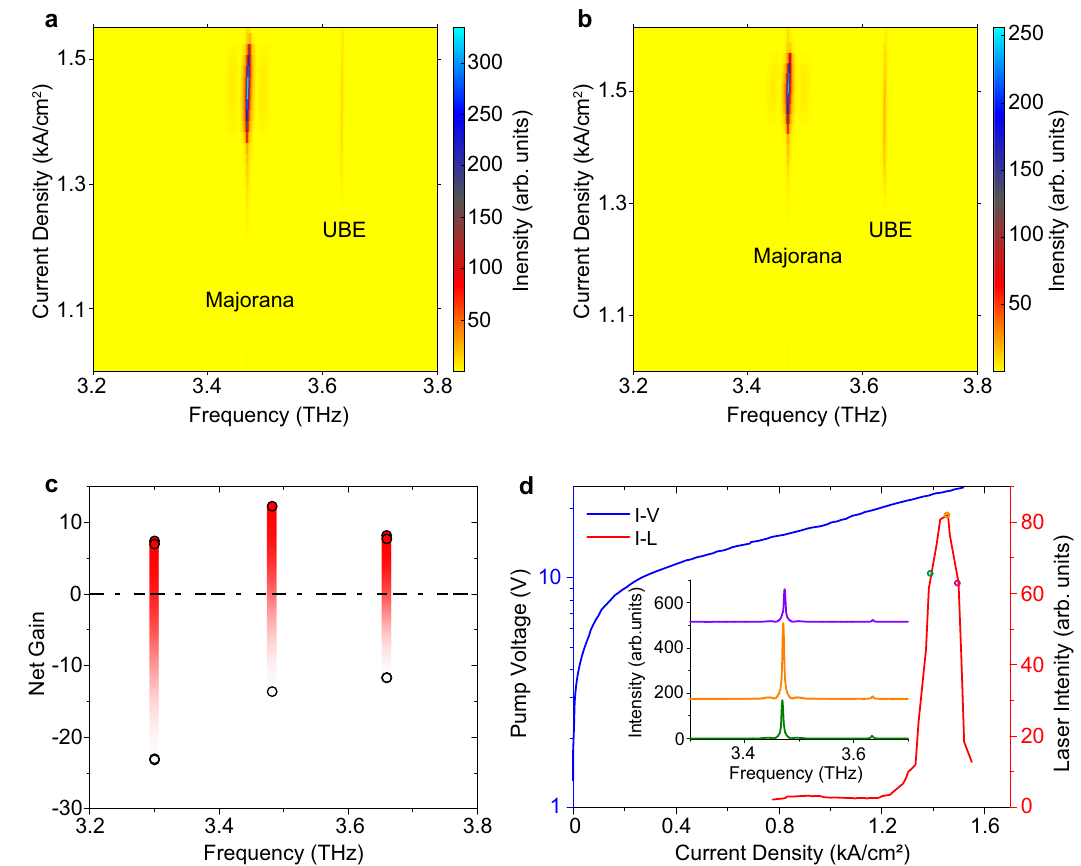
Fig. 3 | Observation of lasing Majorana zero modes. a , b Emission intensity spectra for different pump current densities, obtained using samples with latticeconstant a =30 μ mandwindingnumberof ±1,respectively. c Calculated net gain coef fi cients before and after the laser devices are pumped. d Light- current-voltage (L-I-V) curve for the sample with winding number of +1 (the